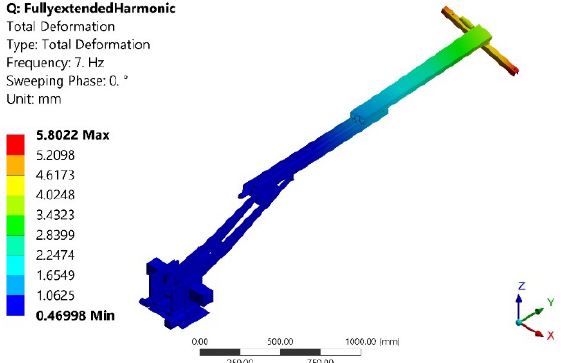
Figure 14. Total deformation (in mm) of the fully-extended configuration structure resulting from the harmonic analysis at the 2nd natural frequency (7 Hz).